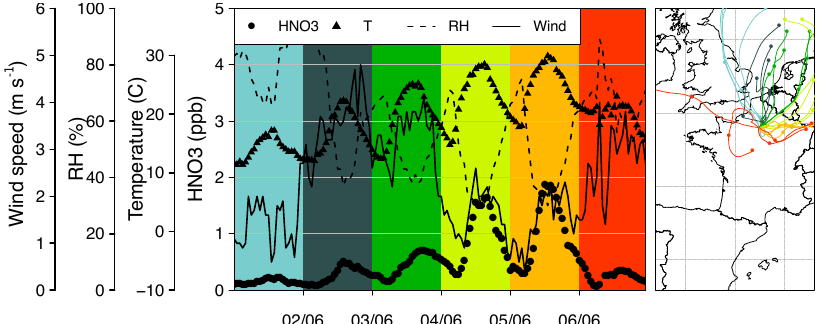
Figure 8. Hourly concentrations of HNO 3 at LHVP and wind speed, RH and temperature during early June 2010 (left panel), and associated 48h back trajectories (one point every 24h) colored by the day of arrival (i.e., red is for 6 June).